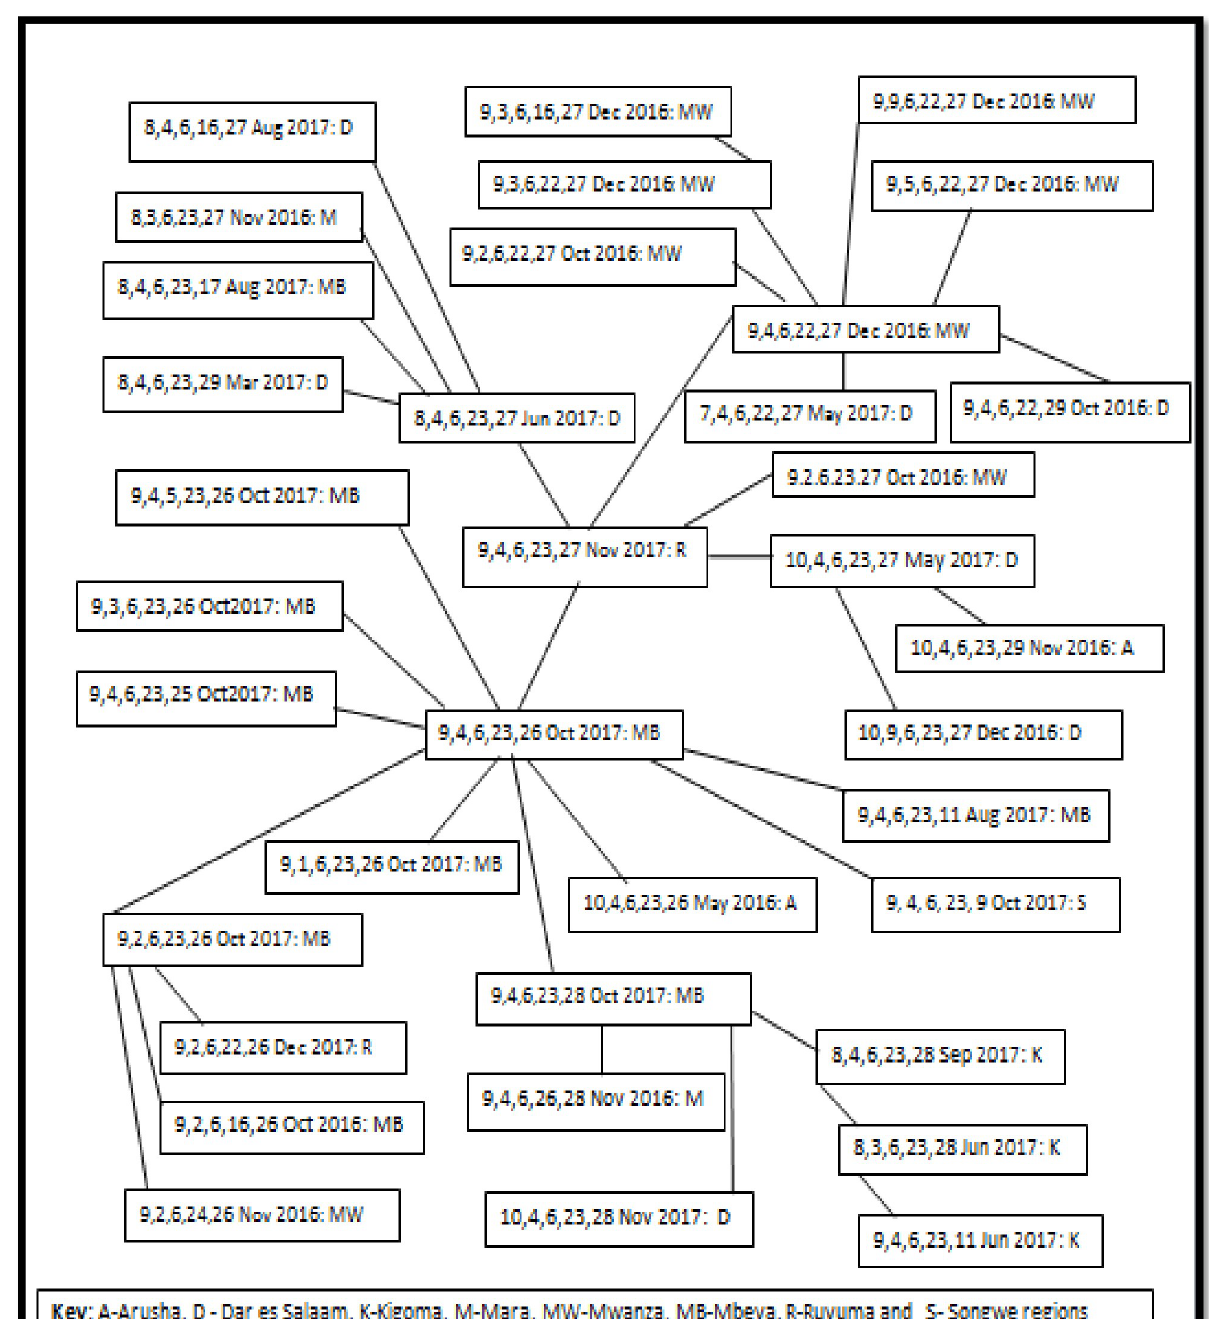
Fig 2. Genetic relatedness between V . cholerae genotypes in CC1 by MLVA, time, and regions. Five numbers represent genotype; each connecting line shows an allelic change at a single locus of a genotype.